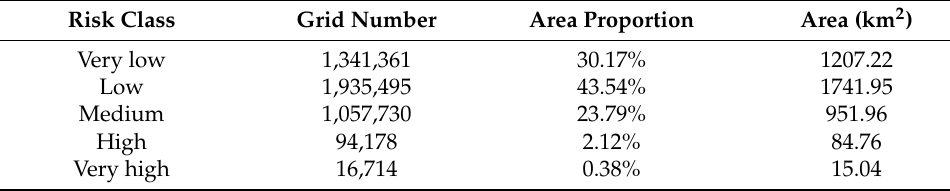
Figure 15. Landslide risk map. Table 9. Statistical result of landslide risk in different